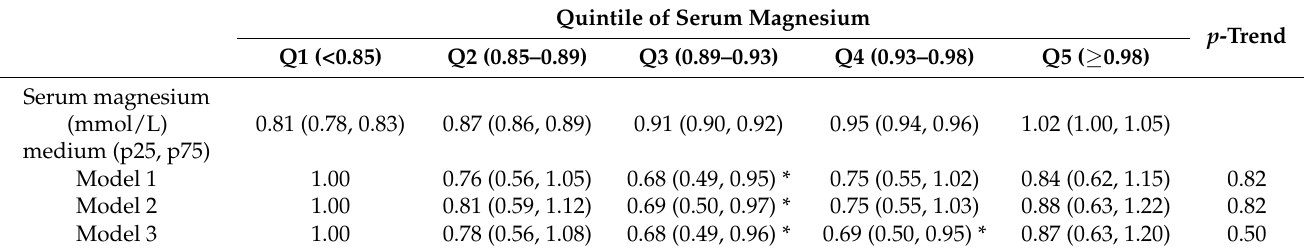
Table 3. Hazard Ratio (HR) and 95% confidence interval (CI) for association between serum magnesium quintiles and Type 2 diabetes risk.